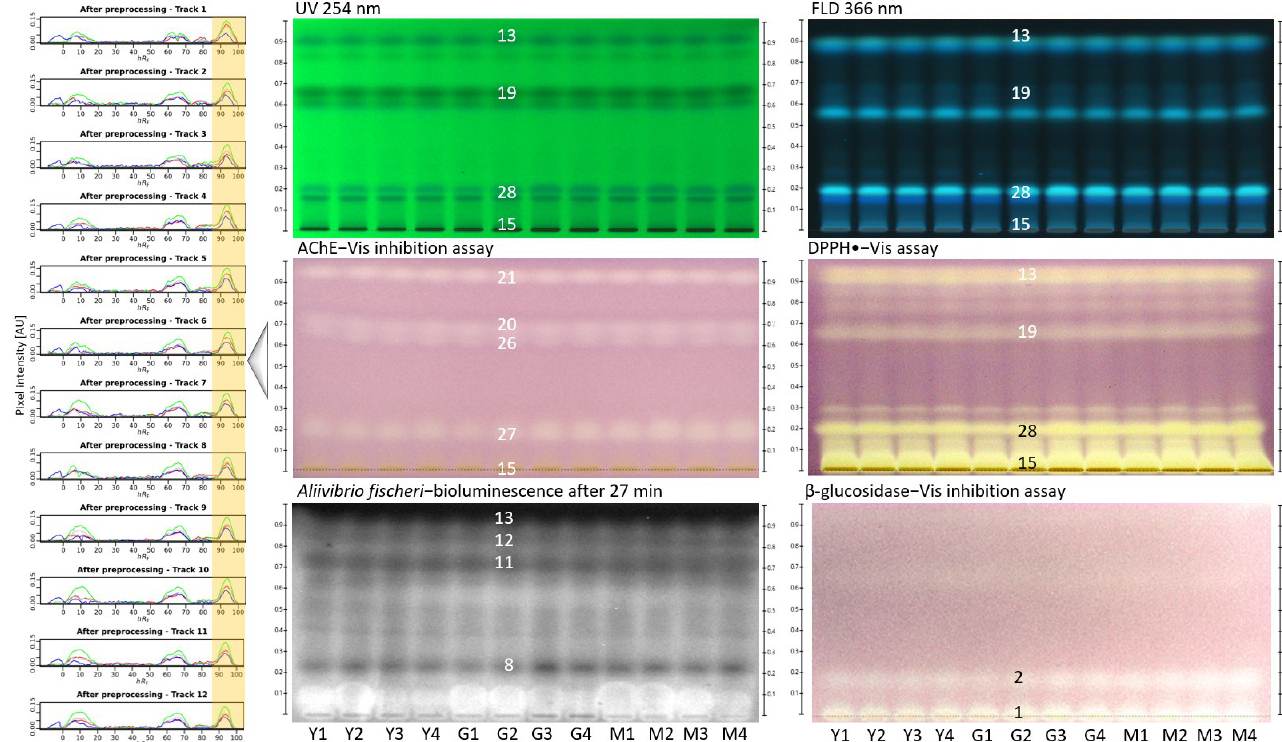
Figure 3. Chromatograms at UV 254 nm and FLD 366 nm and respective effect-directed profiling of 12 Coffea arabica honey extract samples (2 µ L/band each; samples 1 − 4 collected at different sites in the Yayu (Y), Goma (G), and Mana (M) regions, Table 1 developed on HPTLC silica gel 60 F 254 plates with ethyl acetate–methanol 3:2, V / V , detected via the DPPH • radical scavenging assay, AChE and β -glucosidase inhibition assays (white light illumination, Vis), and Aliivibrio fischeri bioassay (bioluminescence after 27 min depicted as greyscale image); AChE inhibition autogram evaluated via quanTLC software to measure the variation of the pixel signal intensity of zone 21 (framed in yellow).